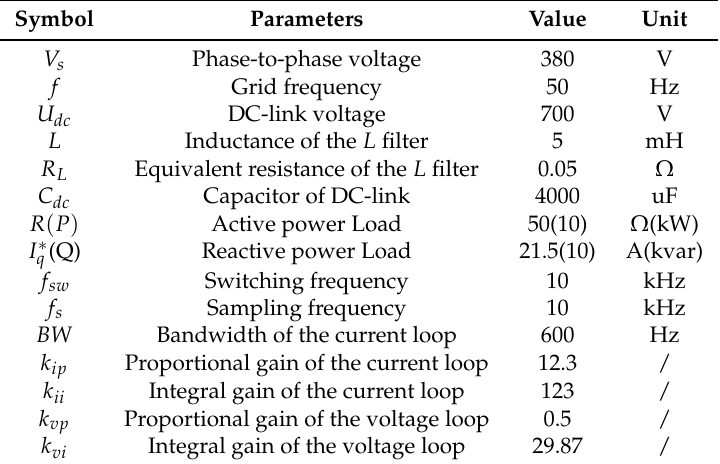
Table 2. Simulation and experimental setup